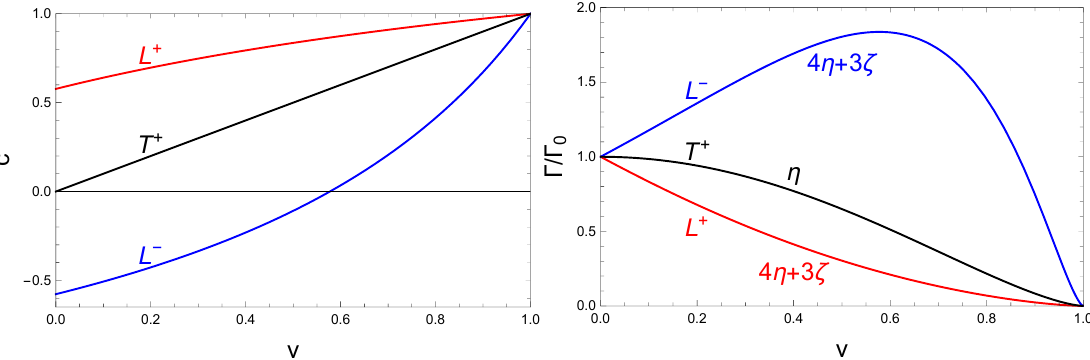
Figure 2. Single-fluid, zero-temperature sound speeds c ( left ) and attenuation Γ ( right ) of the three modes L ± , T + (see first three rows of Table 1) as a function of the boost velocity v . Velocities are given in units of the speed of light, and the attenuation constant is given in units of Γ 0 from Equation (22) for √ L ± and in units of η / w for T + . We have set c ( v = 0 ) = 1/ 3, but any other value of c < 1 yields the same qualitative